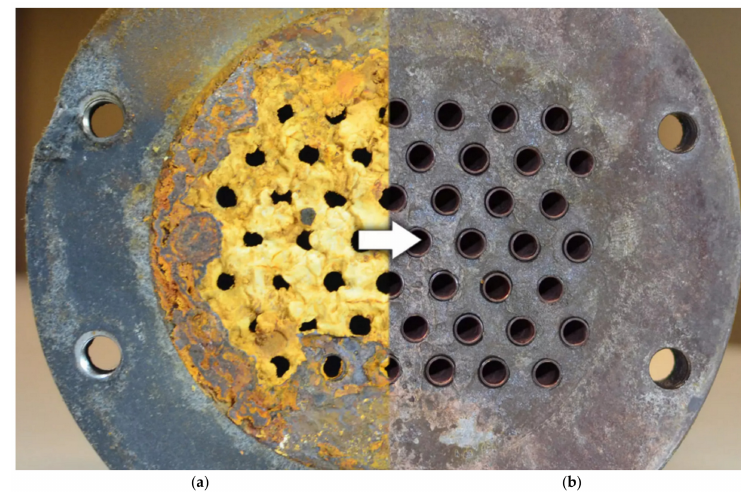
Figure 1. A bundle of heat exchanger tubes in ( a ) fouled state and ( b ) clean state [4]. Fouling occurs in two concurrent sub-processes: a deposit accumulation process and